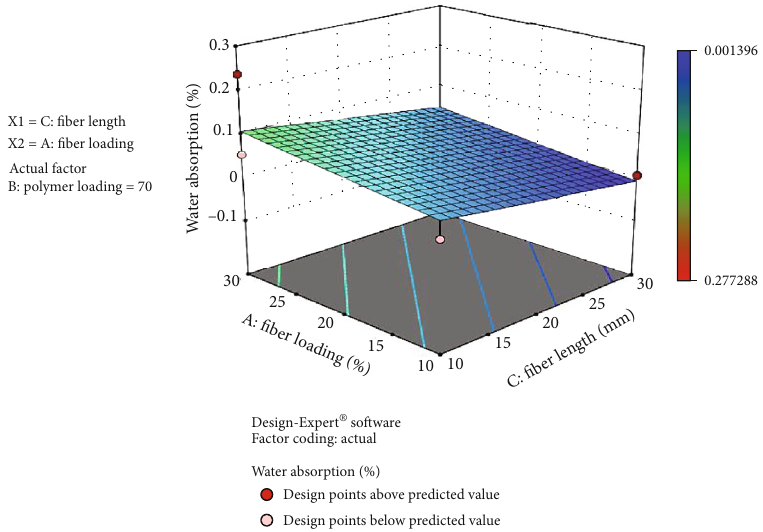
Figure 12: E ff ect of fi ber weight proportion as a function of fi ber length on water absorption.